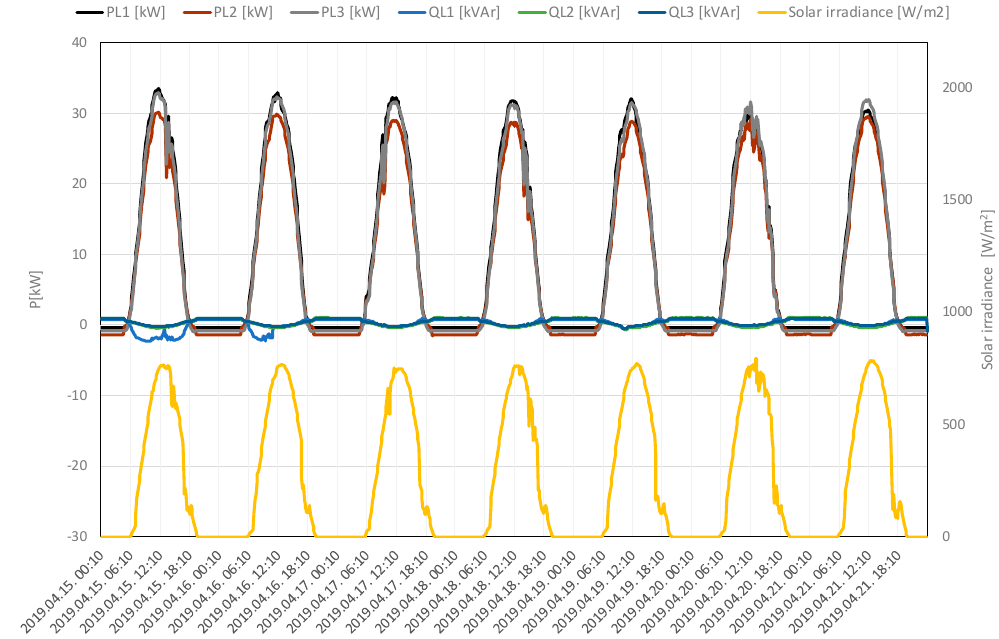
Figure 13. Changes in active (P L1 , P L2 , P L3 ) and reactive (Q L1 , Q L2 , Q L3 ) power in specific phases in point of common coupling (PCC) of PV power plant PV-C and changes in solar irradiation in the examined week.